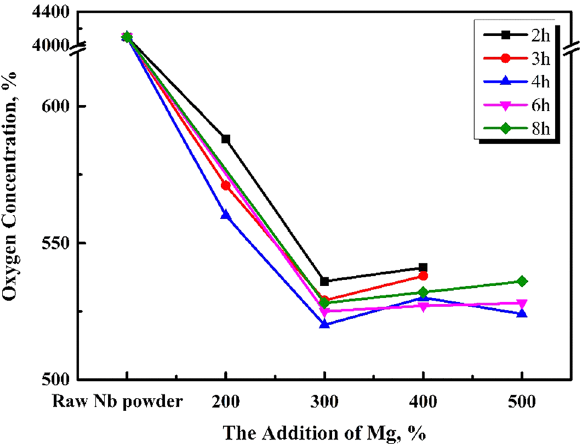
Figure 3. Effect of magnesium addition and reduction time on the oxygen content of pickling niobium powder at 1053